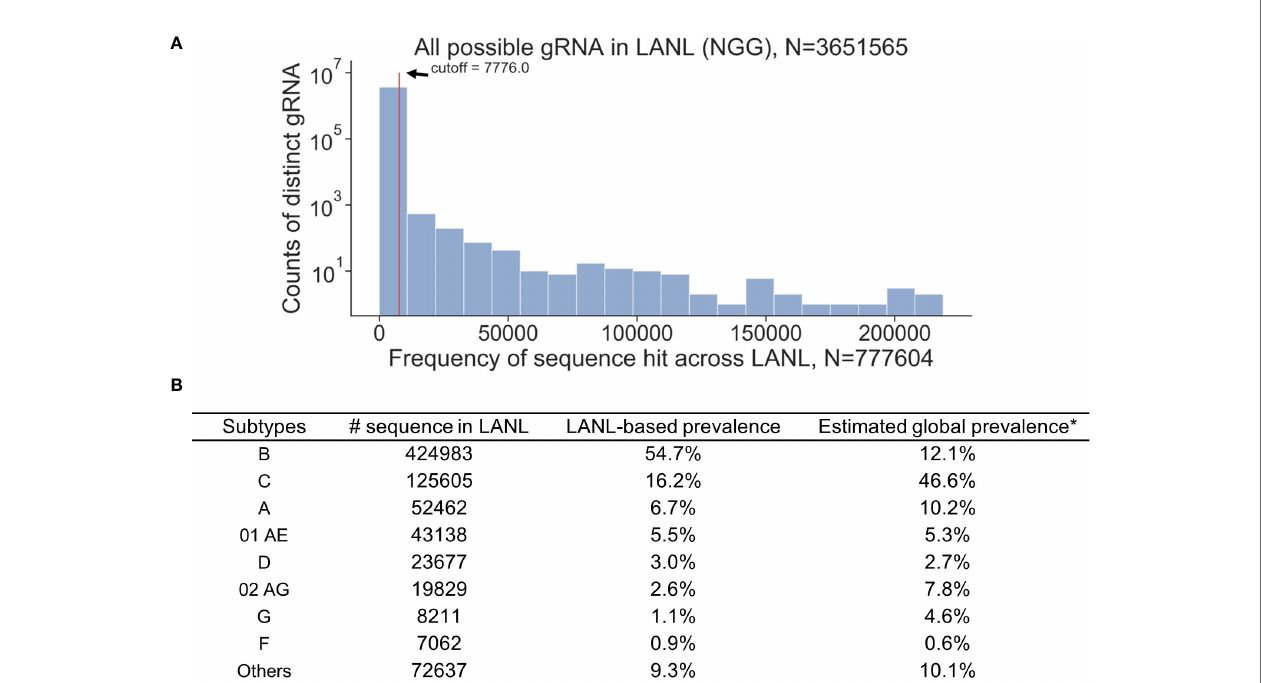
FIGURE 1 | K-mer exhaustive search of all possible distinct 20-bp sequences adjacent to SpCas9 PAM (NGG) using 777,604 HIV-1 sequences across all reported subtypes in the LANL database. (A) Distinct 20-bp sequences with high frequencies (seen 1% of time or more; N>7776) in the LANL database were selected as candidate gRNAs. (B) The proportion of sequences attributed to each subtype does not represent the global prevalence. Estimated global prevalence was adopted from Hemelaar et al.